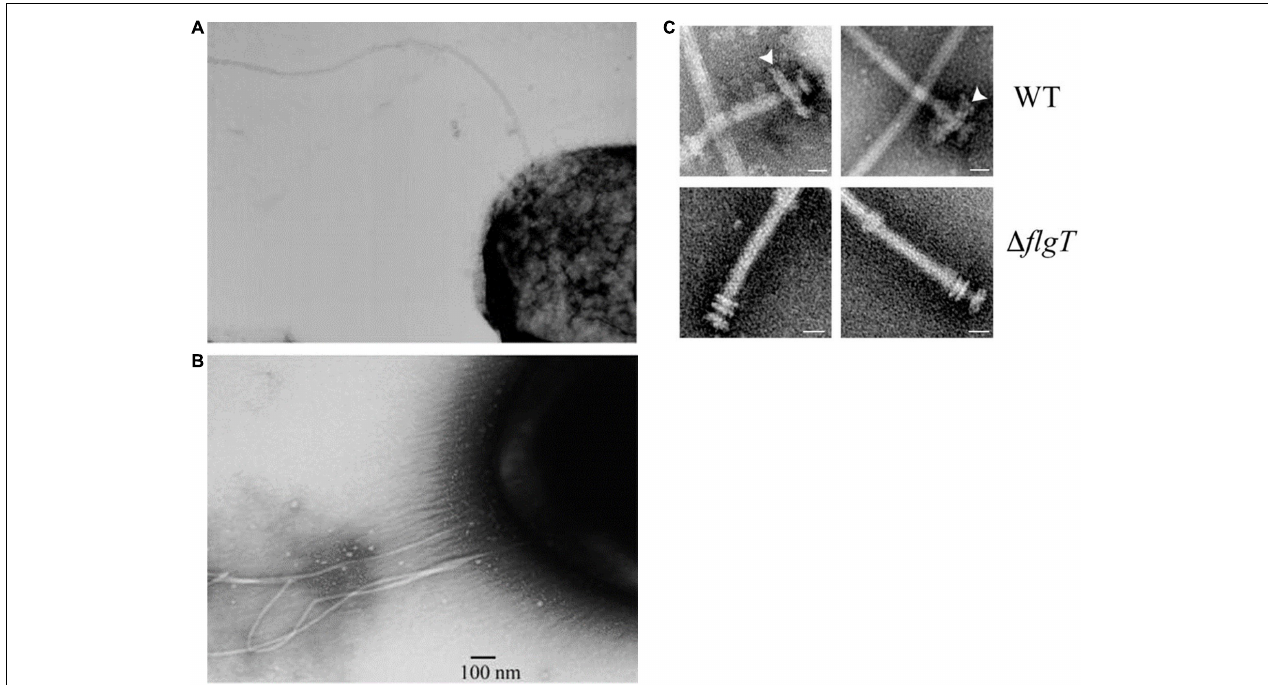
FIGURE 2 | Electron micrographs showing (A) single unidirectional flagellum expressed under laboratory conditions, Fla1. (B) Polar tuft of flagella, Fla2 expressed from CtrA controlled regulon when Fla1 is repressed. (C) Additional ring associated with L/P ring of Fla1, lost in FlgT mutants. Taken from Poggio et al. (2007) and Fabela et al. (2013) with